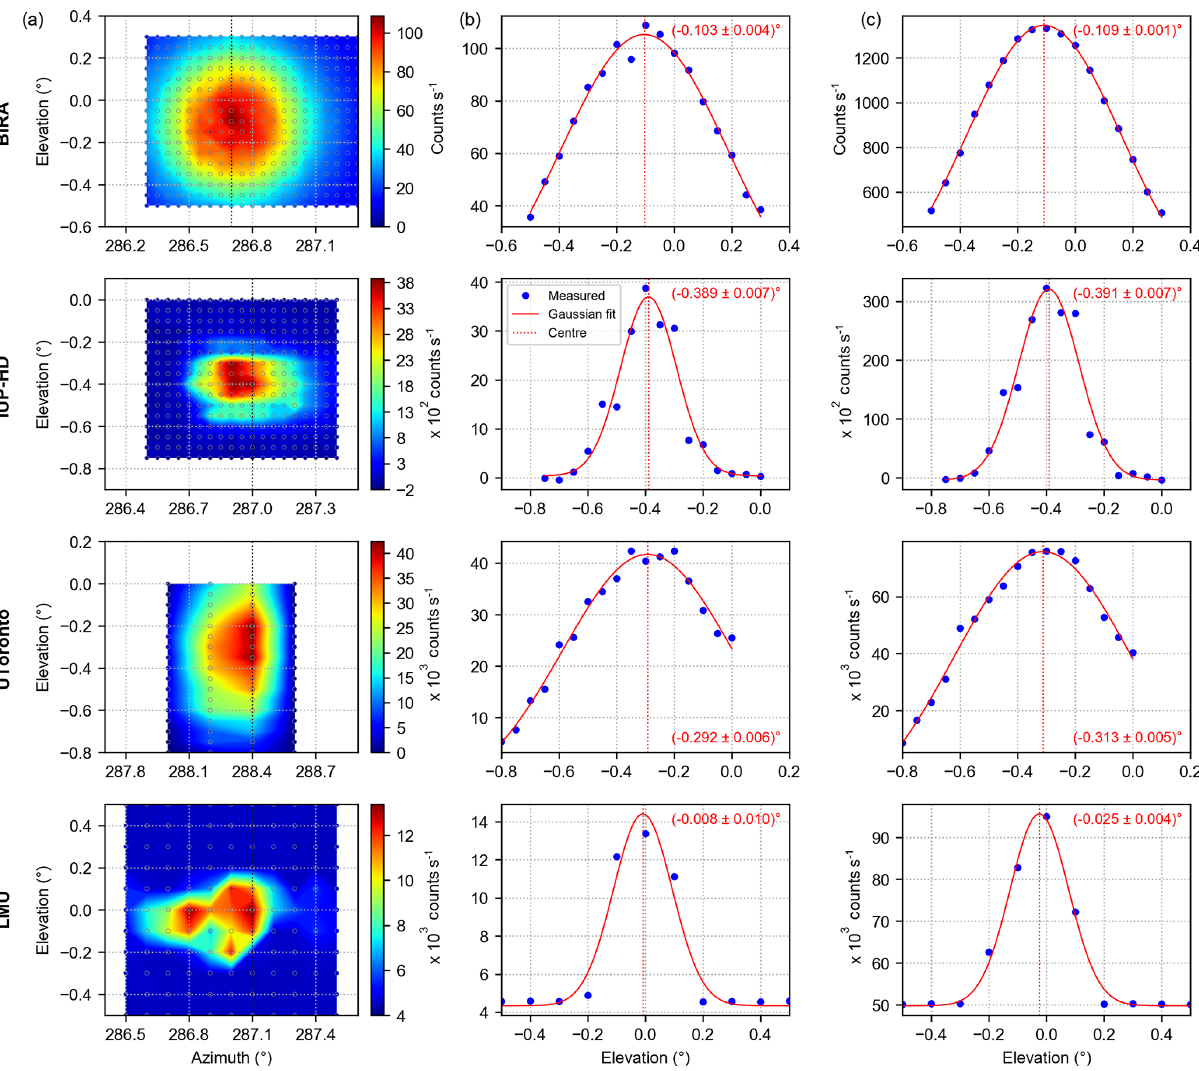
Figure 11. (a) shows examples of the 2-D intensity distributions for the BIRA UV (at 365nm, measured on 10 September), IUP-HD UV (at 365nm, measured on 13 September), UToronto (at 436nm, measured on 10 September) and LMU (mean intensity, measured on 10 September) instruments. (b) and (c) show the corresponding transects along the dashed black lines in (a) and the azimuthal sum of the intensities at the different elevations, respectively. Additionally, the respective Gaussian fits and their centres are